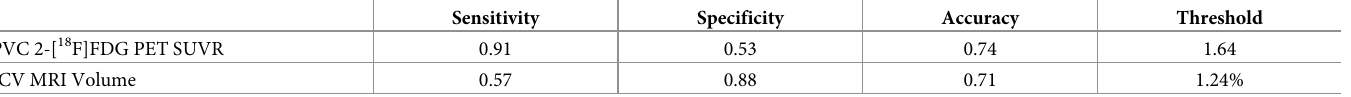
Calculated thresholds of the average value of striatum from both hemispheres with related sensitivity, specificity and accuracy. SUVR: standardized uptake value relative to cerebellar